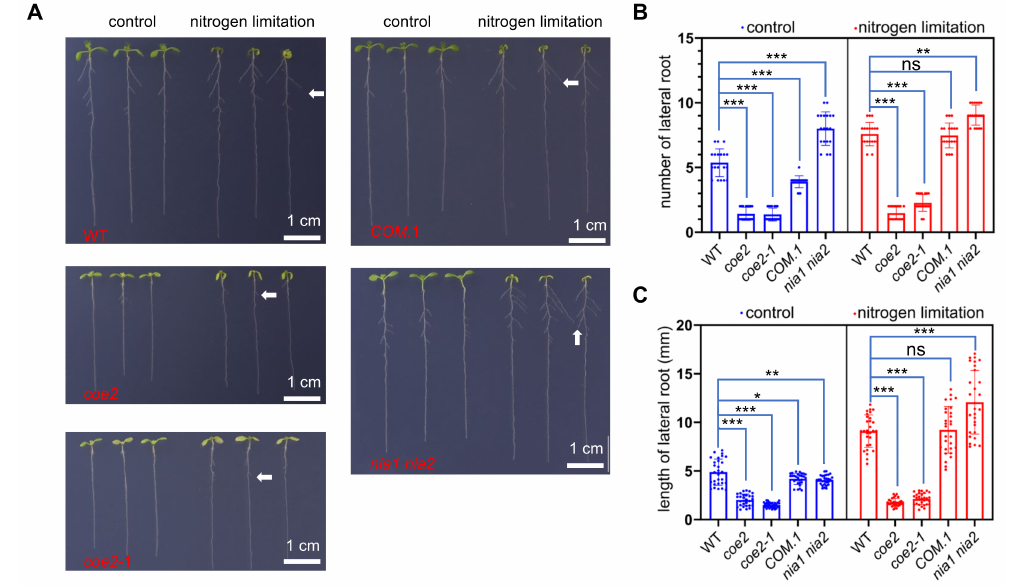
Figure 7. COE2 is involved in regulating the development of lateral roots under nitrogen limitation conditions. ( A ) Growth of seedlings of WT, coe2 , coe2-1 , COM.1 , and nia1 nia2 under control and